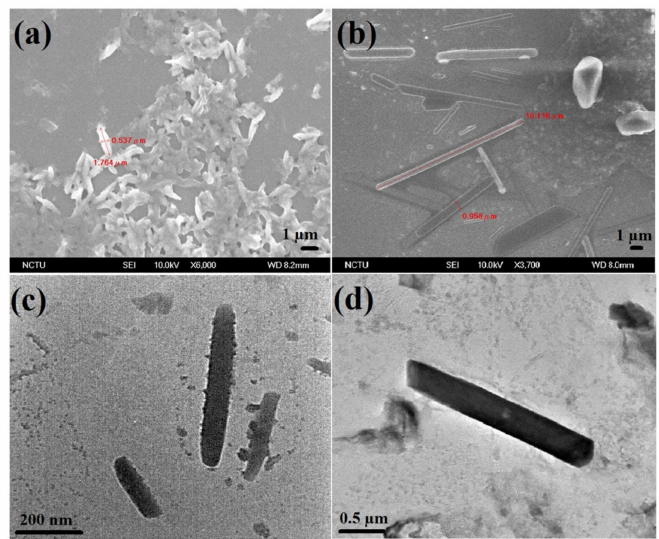
Figure 6. ( a ) and ( b ) SEM images of Cd 2+ - NDS1 NWs (10 µ g/mL in water) at different regions (scale: 1 µ m) ( c ) and ( d ) TEM images of Cd 2+ - NDS1 NWs (1 ng/mL in water) at different regions (scale: 200 nm and 0.5 µ m,